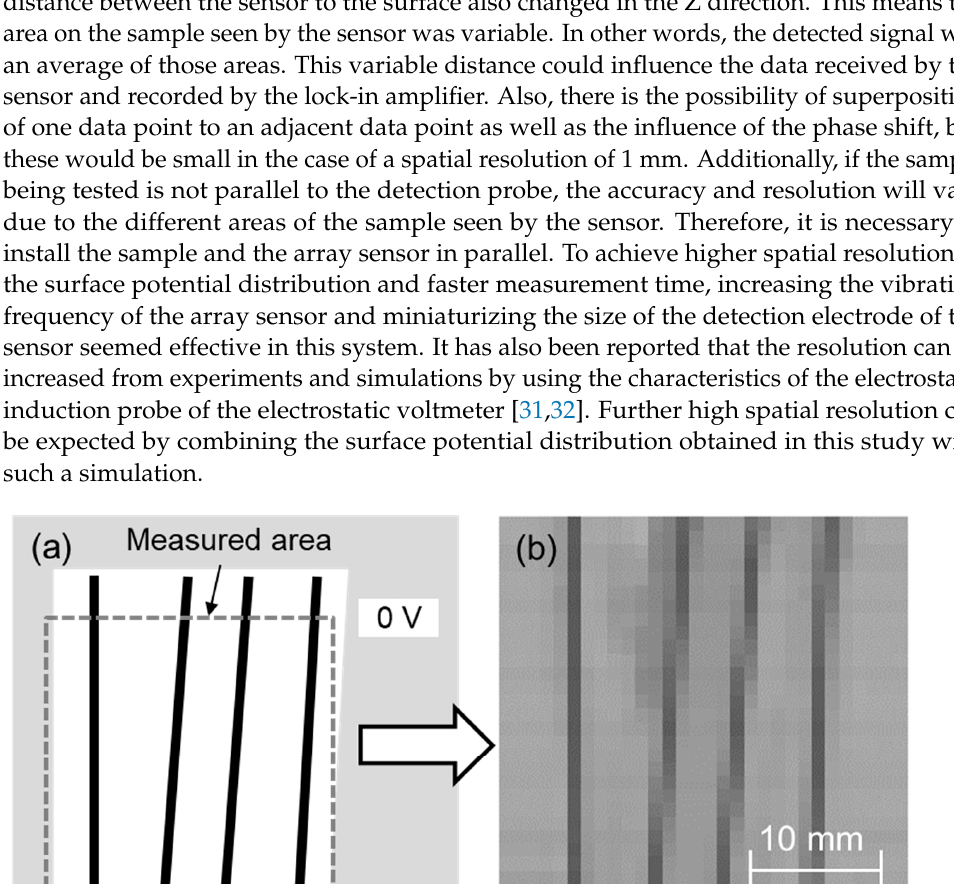
Figure 9. ( a ) Surface potential distribution of charged glass upon contacting vinyl chloride and ( b ) surface potential distribution after eliminating static.